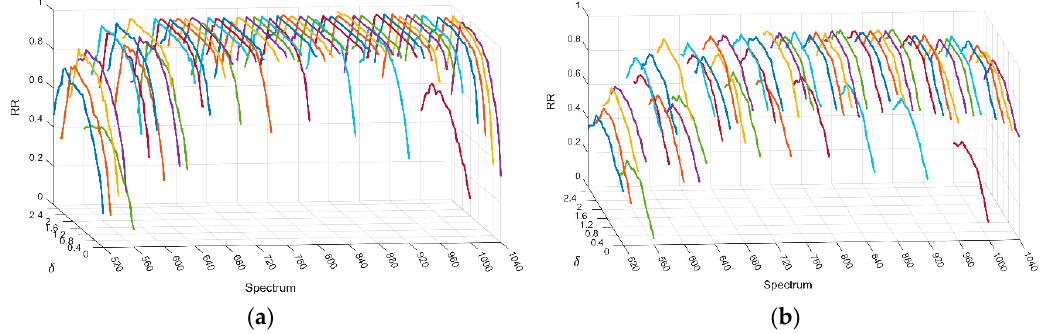
Figure 9. Recognition rates (RR) with different acutance (corresponding to δ ) for every band (spectrum) of HDHV using different local texture patterns. Results using the feature extraction methods of ( a ) regional local binary patterns (LBP); ( b ) deep features.